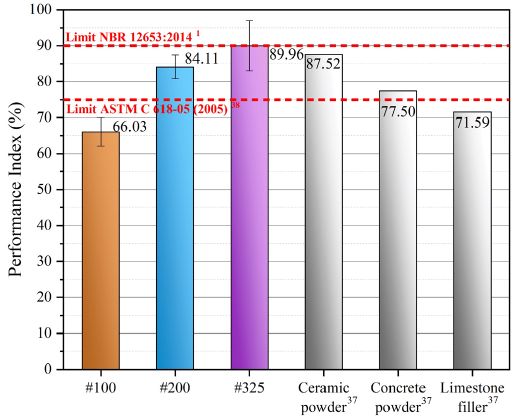
Figure 8. Performance Index with Portland cement and added glass powder of three different grain sizes and comparison with ceramic and concrete waste powders, as well as limestone fillers 37